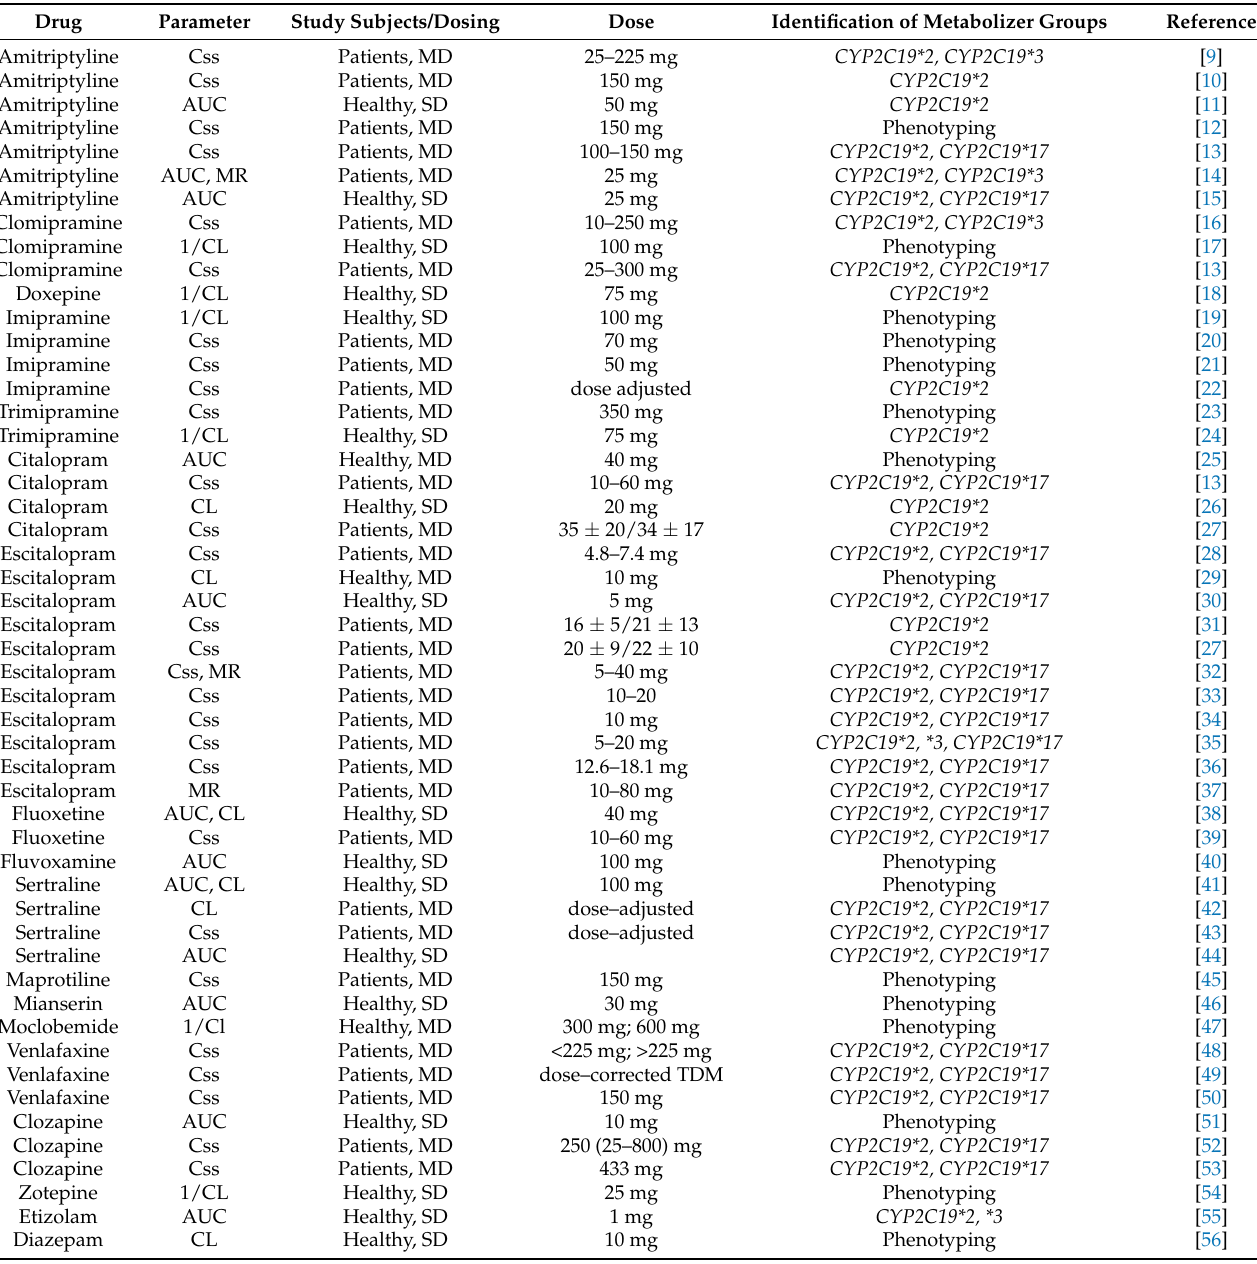
Table 1. Studies included in the analysis and their